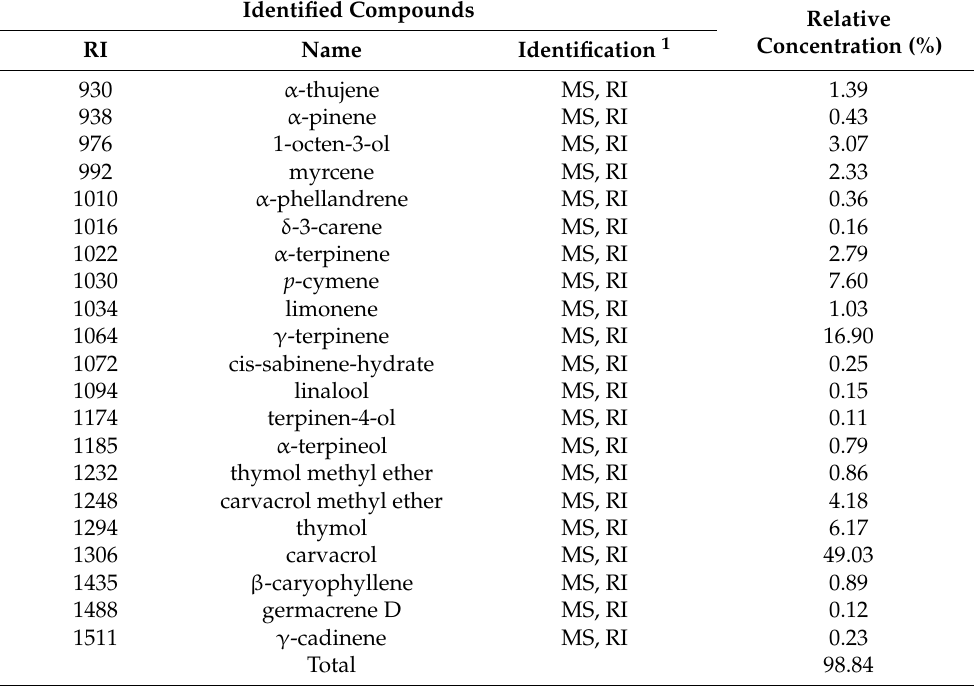
Table 1. Composition of M. didyma L. essential